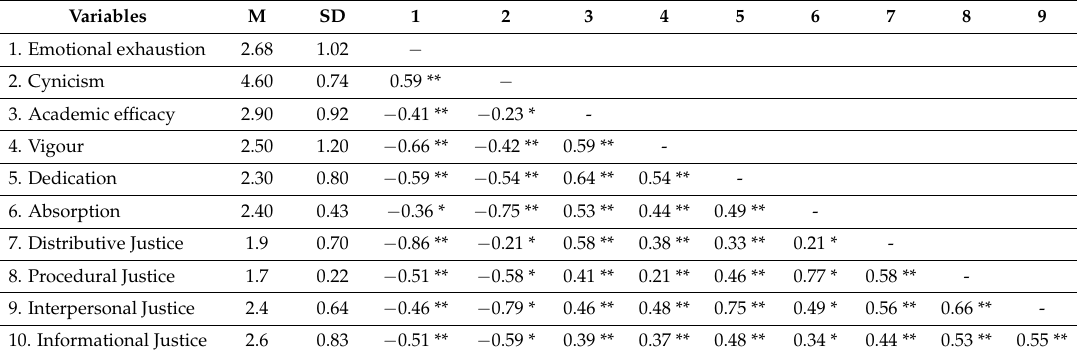
Table 1. Means (M), Standard Deviations (SD) and Intercorrelations between variables ( N = 543).